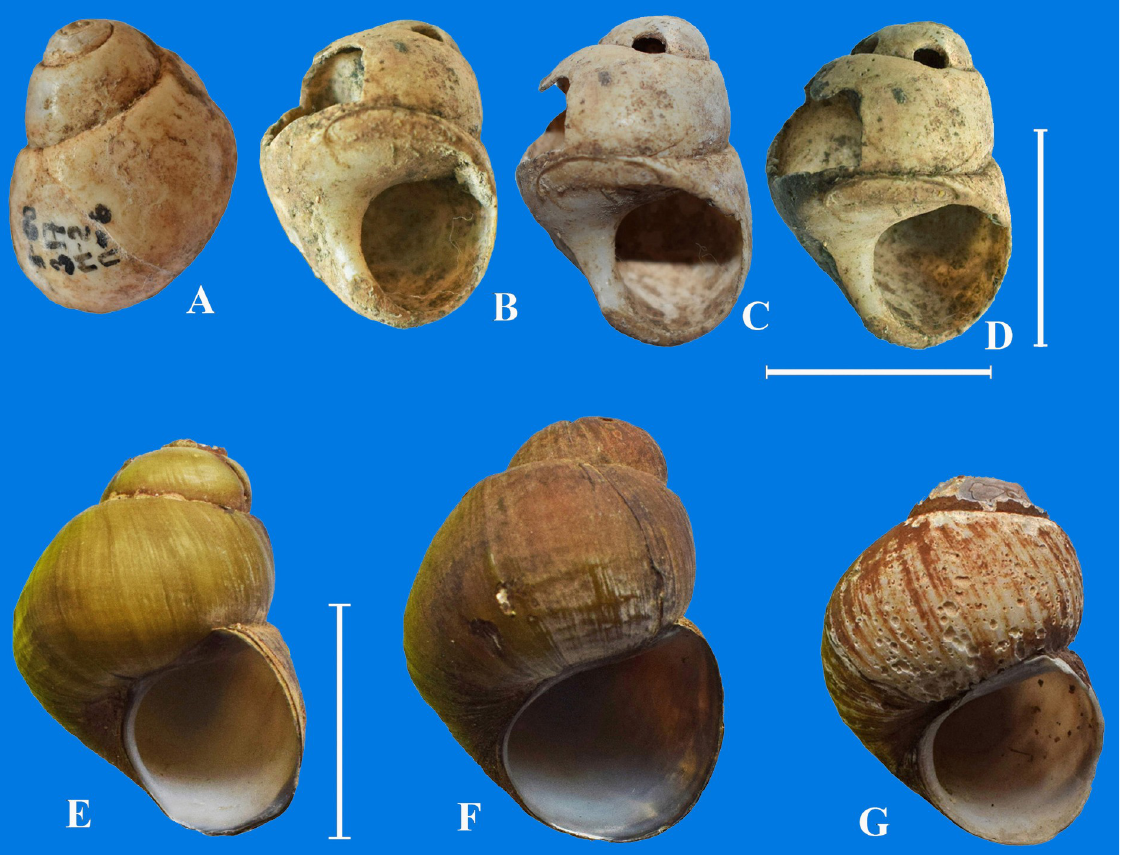
Fig 10. Shells of Amuropaludina praerosa . A-D–view of a subfossil shell A . praerosa in different perspective from the Zorgol burial ground, E-G–recent shells of A . praerosa from the Middle Amur River. Scale bar 2 cm.